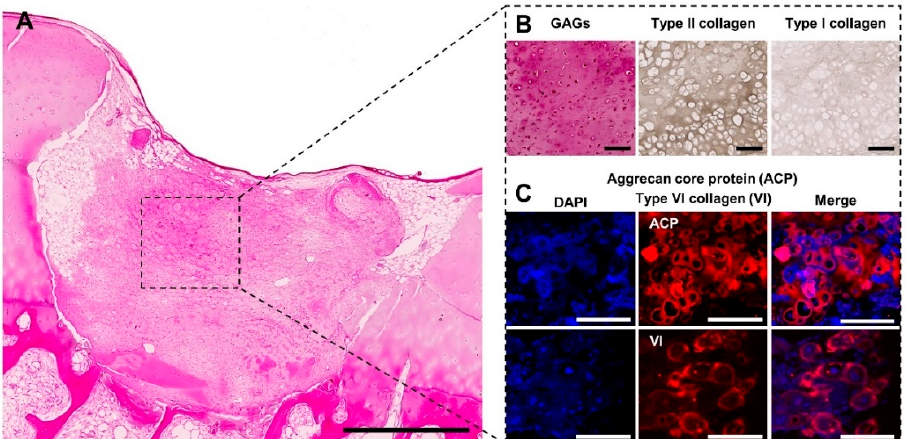
Figure 6. Scheme of the in vivo study. ( A ): Following extraction and monolayer expansion, HACs were seeded in fibrin hydrogel and cultured for 3 weeks in a direct perfusion bioreactor. Cartilage constructs were then fixed in fresh human osteochondral blocks with fibrin sealant and hybrid constructs were implanted into the subcutaneous pockets of nude mice for 6 weeks. The stability of the neo-synthesized matrix was assessed by histology. ( B ): Macroscopic pictures showing (left to right) the cartilage gel fixed in the human osteochondral block from top and side views as well as the hybrid construct implanted under mouse skin.